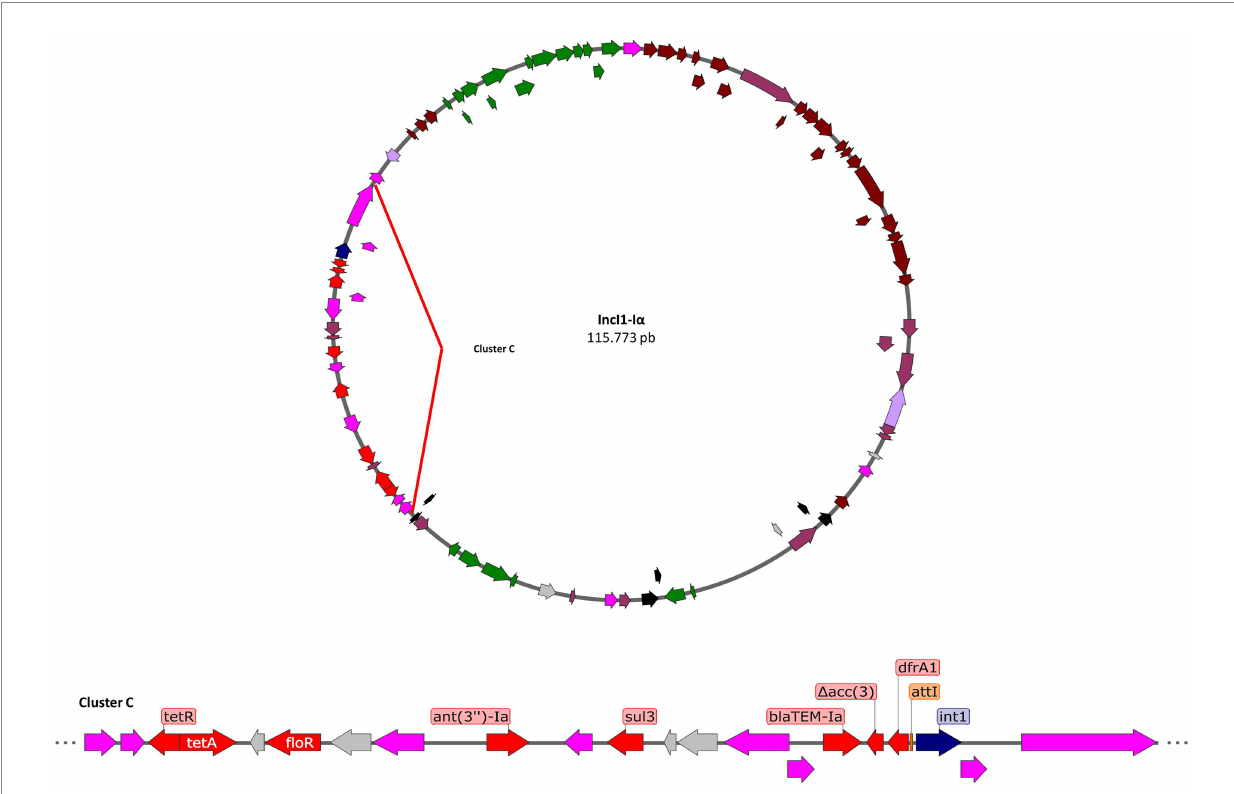
FIGURE 4 Genomic contexts of the resistant genes (red arrows) in plasmid IncI1-I α . Transposons in fuchsia arrows, integrases in blue arrows, sequence of integration in orange rectangles, antibiotic resistance genes in red arrows, metal resistance genes in yellow arrows, virulence genes in green arrows, conjugation genes in brown arrows, and other passenger genes in gray arrows.